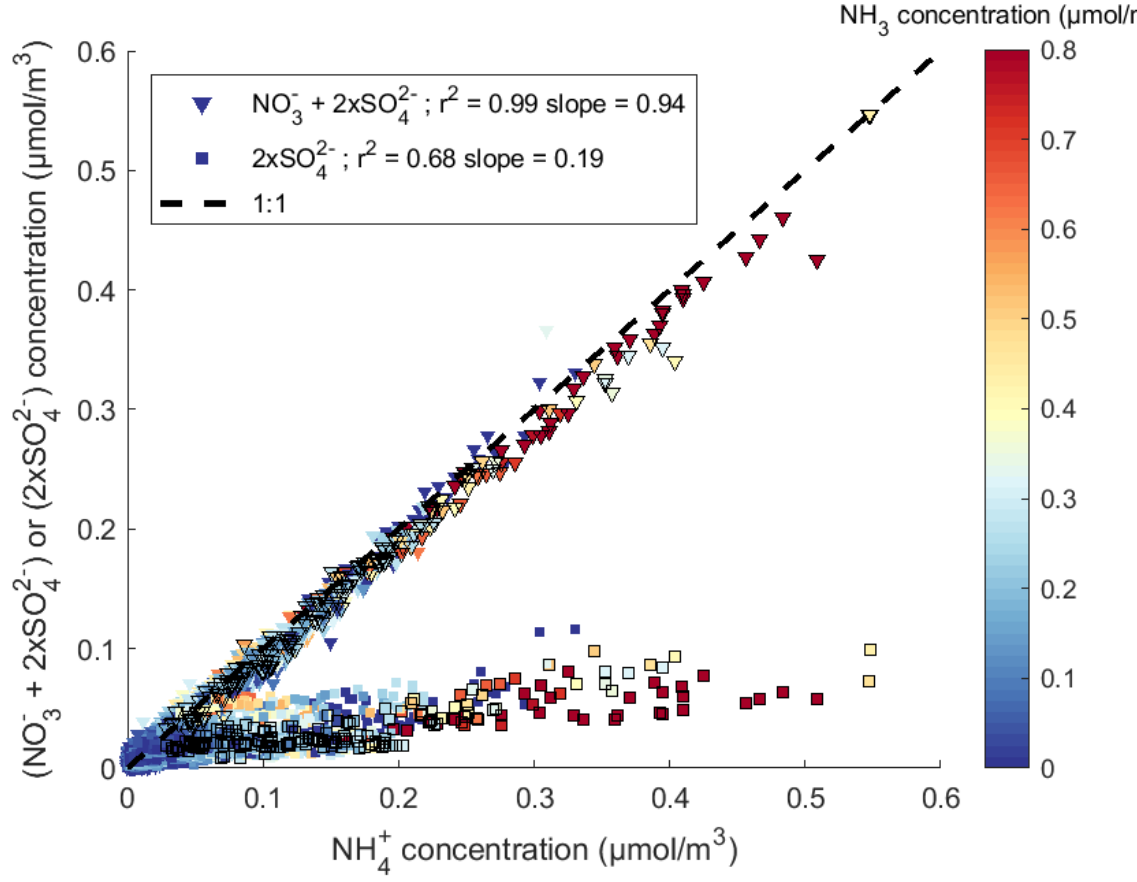
Figure 5. Molar concentrations of 2xSO 42 − + NO 3 − (triangles) and 2xSO 42 − (squares) versus NH 4+ , color coded by NH 3 molar concentrations measured in Paris from January to June 2020. Concentrations measured during the five pollution events are represented with black marker edges.